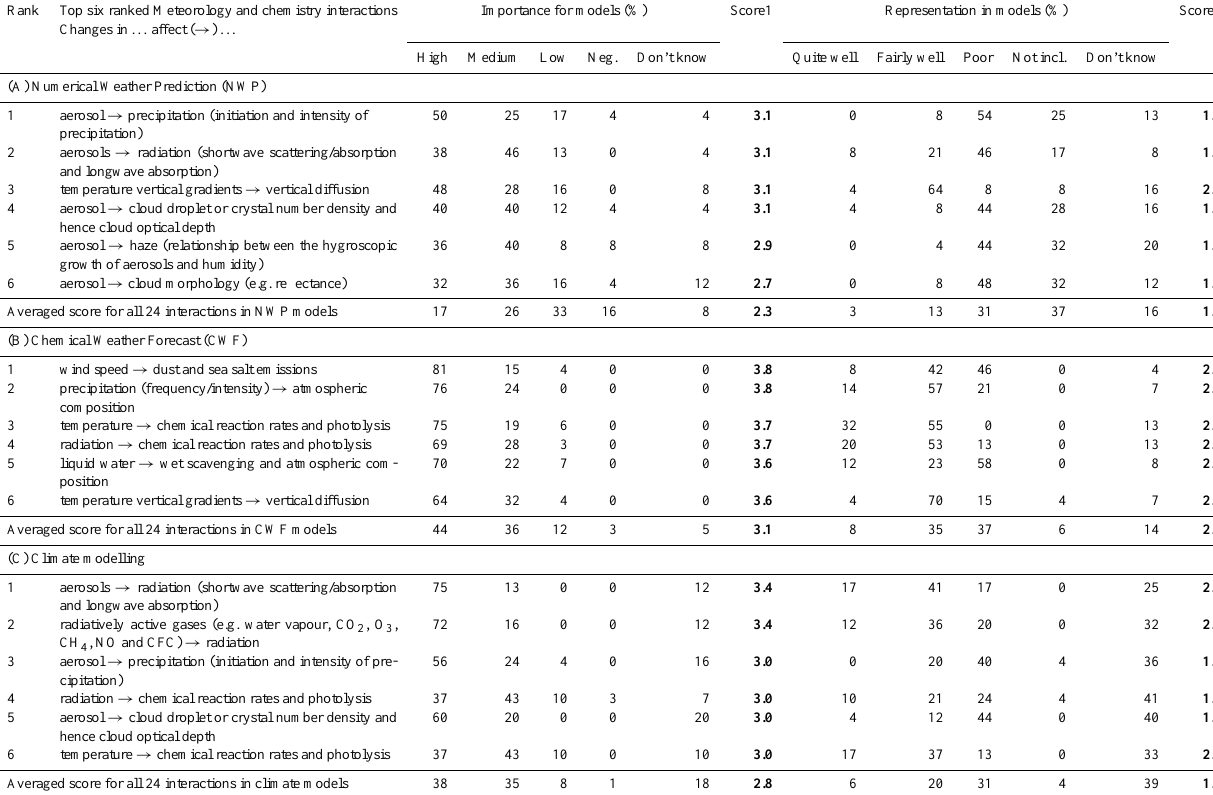
Table 3. Summary of the survey (based on 30 participants) on expert assessment of the most important meteorology and chemistry interac- tions for online MetChem models. Only the top six ranked important interactions (out of 24 total interactions in the survey questionnaire) for each model category (NWP, CWF and climate) are reported here. Score 1 is an indicator for ranking the “importance of the interaction” from the weighted mean of: 4 = high, 3 = medium, 2 = low and 1 = negligible; while score 2 is another indicator for ranking the “adequacy of the representation of the interaction in models” as the weighted mean of: 4 = quite well; 3 = fairly well; 2 = poor; 0 = not included. Rank Top six ranked Meteorology and chemistry interactions Changes in ... affect ( → )